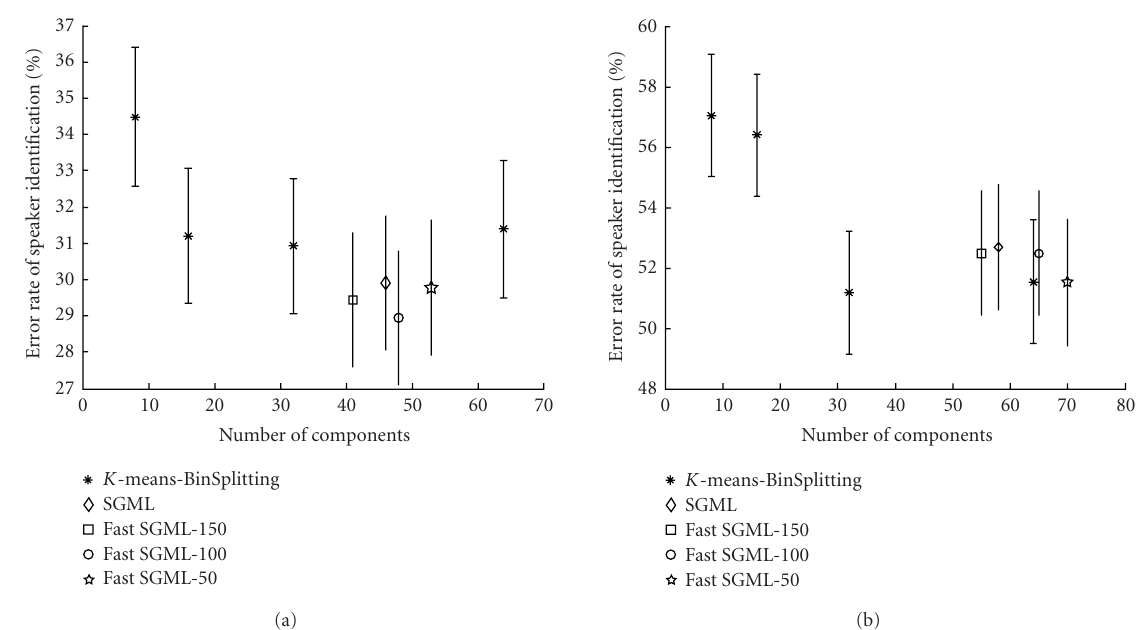
Figure 6: The error bars obtained by applying a bootstrap resampling procedure to the case of 90-second training speech and variable-length testing speech. (a) The male speaker case. (b) The female speaker